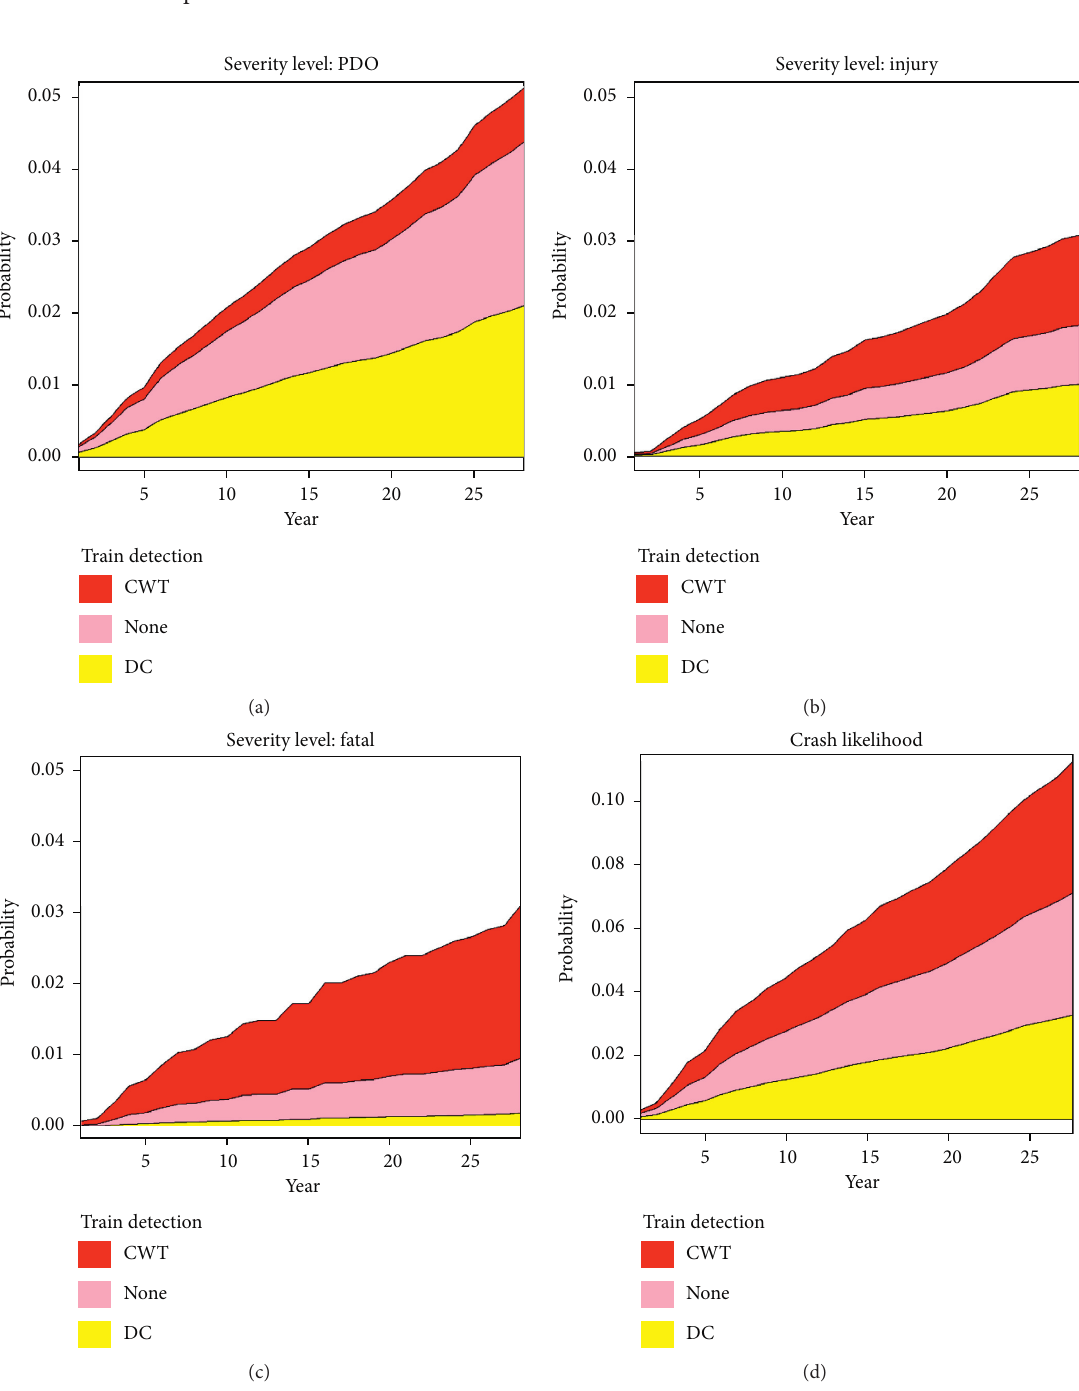
Figure 3: Cumulative probabilities of crash severity and crash occurrence for train